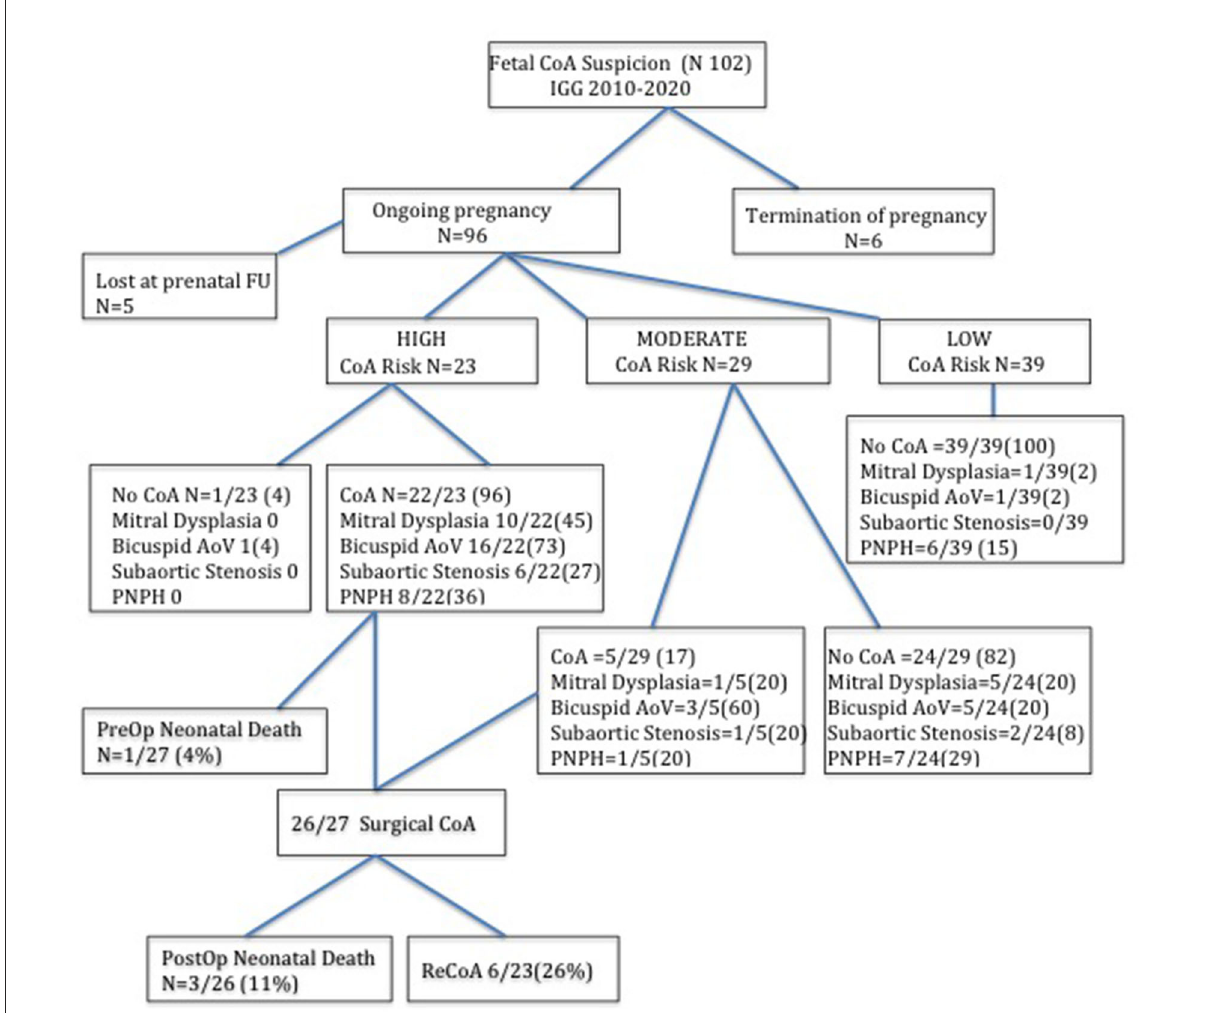
FIGURE2 Flow chart of fetuses with suspected coarctation of aorta according to the prenatal risk stratification at last fetal echocardiography and the postnatal findings. The number between brackets indicates the